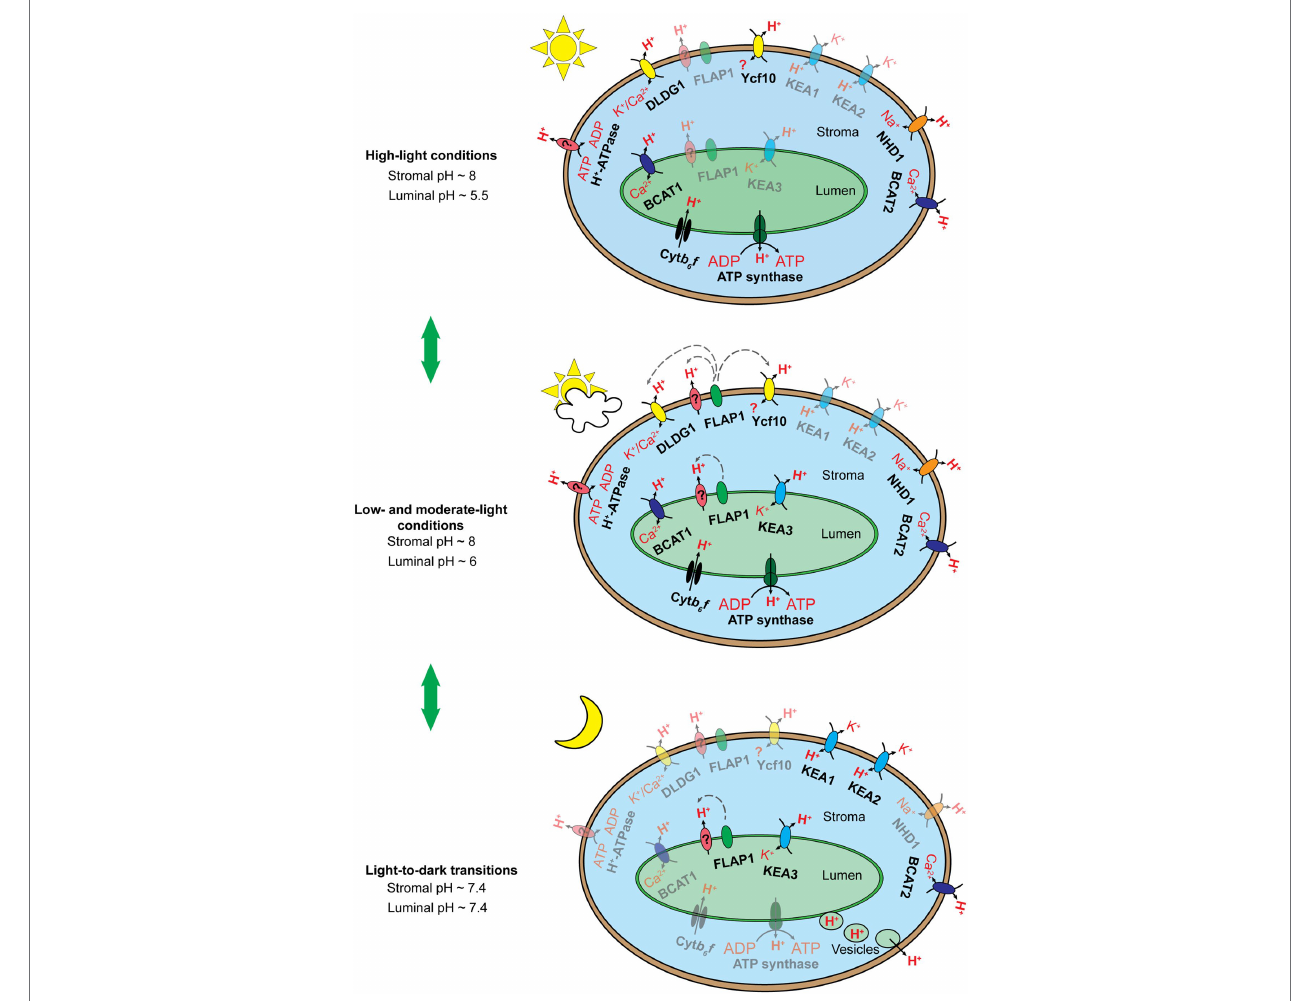
FIGURE 3 | Schematic illustration of the hypothesized chloroplast pH homeostasis via H + transport pathway involving chloroplast membrane-localized transporters, exchangers, and protein complexes under high light conditions (top), low and moderate light conditions (middle), and upon light-to-dark transitions (bottom). The number of proteins shown does not reflect the molecular stoichiometry between them. Black arrows indicate ion/H + flow. Gray dashed arrows indicate the inductive effect of a regulator toward its target transporters. Fully active transporters, exchangers, and protein complexes are 100% opaque, whereas their less active or inactive counterparts are shown with ~50% opacity. The Cyt b 6 f complex and chloroplast ATP synthase are activated by light-induced electron transfer chains and the pmf , respectively, under light conditions (top, middle) and are deactivated upon light-to-dark transitions (bottom). KEA3 performs little function under high light conditions (top) but more function under low and moderate light conditions (middle), as discussed by Armbruster et al. (2016). We proposed that KEA3 also acts to neutralize chloroplast pH upon the light-to-dark transition (bottom). FLAP1 potentially regulates an unknown H + transporter and/or exhibits functional interaction with DLDG1 and Ycf10, as suggested previously (Harada et al., 2019; Inago et al., 2020). FLAP1 relaxes NPQ induction and shows higher activity under low and moderate light conditions (middle) than under high light conditions (bottom), as discussed previously (Sato et al., 2017; Trinh et al., 2019). We proposed that FLAP1 also contributes to the neutralization of chloroplast pH upon light-to-dark transitions (bottom). BICAT1 uptakes Ca 2+ under light conditions (Frank et al., 2019). The bicat1 mutants showed lower NPQ induction (Wang et al., 2016; Frank et al., 2019), although BICAT1 is proposed to transport H + from the thylakoid lumen to the chloroplast stroma. This can be explained by the loss of OEC in the bicat1 mutants, because of the reduction in the Mn 2+ content of chloroplasts, which suppresses either light-induced electron transfer chains or H + translocation across thylakoid membranes (Schneider et al., 2016). Next, BICAT1 functions under light conditions (top, middle), as shown by Frank et al. (2019). As Ca 2+ accumulation in the chloroplast stroma contributes to the downregulation of CO 2 fixation, because of the inhibition of several enzymes involved in the CBB cycle (Rocha and Vothknecht, 2012), and to the transcription of plastidial genes via the synthesis of the secondary messenger, guanosine tetraphosphate (Ono et al., 2019), BICAT1 is proposed to be deactivated upon the light-to-dark transition (bottom). Both KEA1 and KEA2 antiporters are less active under light conditions (top, middle) than upon light-to-dark transitions (bottom), as reported previously (Aranda Sicilia et al., 2021). The BICAT2 antiporter is active under light conditions (top, middle), as reported by Frank et al. (2019). As mentioned above, Ca 2+ uptake by the chloroplast stroma is essential for the suppression of CO 2 fixation under stress conditions and upon light-to-dark transitions. Thus, we proposed that BICAT2 is activated upon light-to- dark transitions (bottom). DLDG1, Ycf10, NHD1, and H + -ATPase are all proposed to contribute to H + extrusion into the cytosol, thus contributing to the maintenance of alkaline pH in the chloroplast stroma under light conditions (top, middle). The functions of proteins are deactivated upon light-to-dark transitions (bottom). Direct H + export from the thylakoid lumen to the cytosol is proposed to occur upon light-to-dark transitions (bottom) to neutralize the luminal pH. This mechanism might occur at contact sites between thylakoid and envelope membranes (data not shown) or through vesicle transport from thylakoids to chloroplast envelope membranes